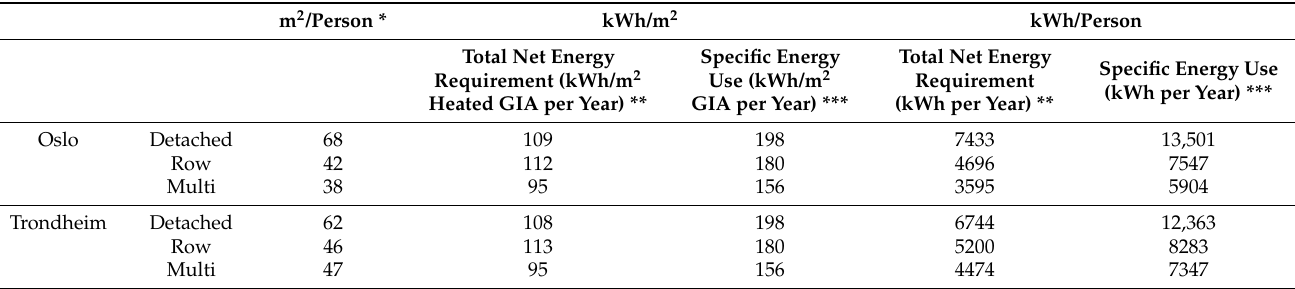
Table 1. Calculated energy use per person per dwelling